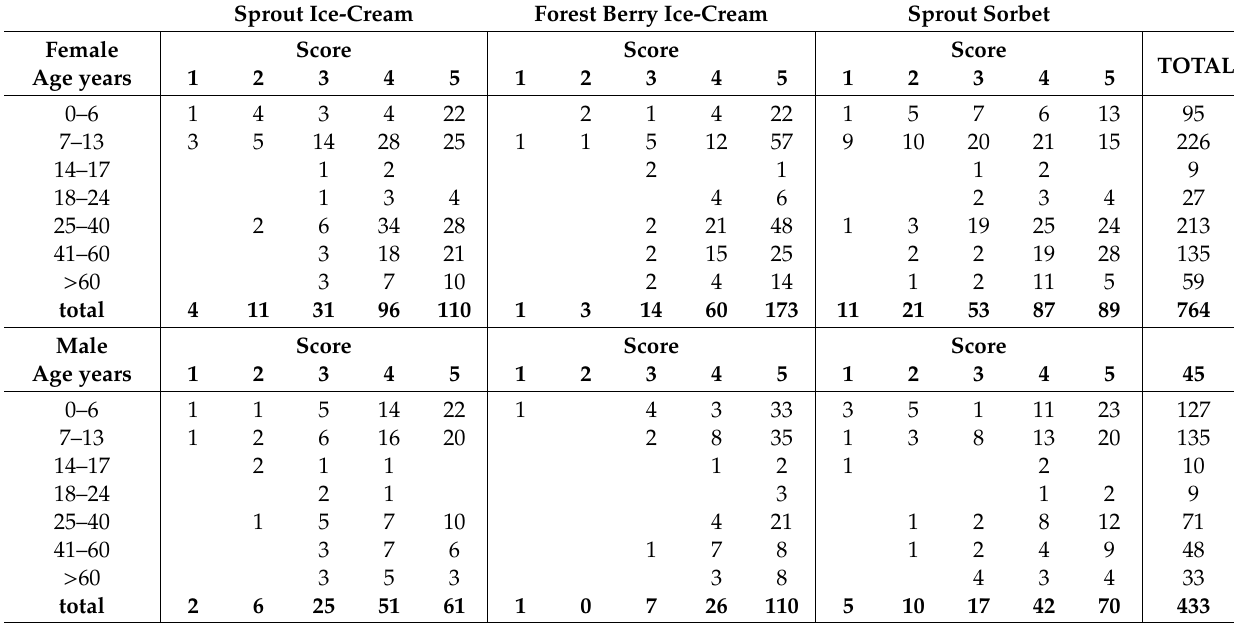
Table 5. Results of consumer acceptance evaluation of frozen desserts with sprouts (ice-cream and sorbet) and reference product (forest berry ice-cream). The sum